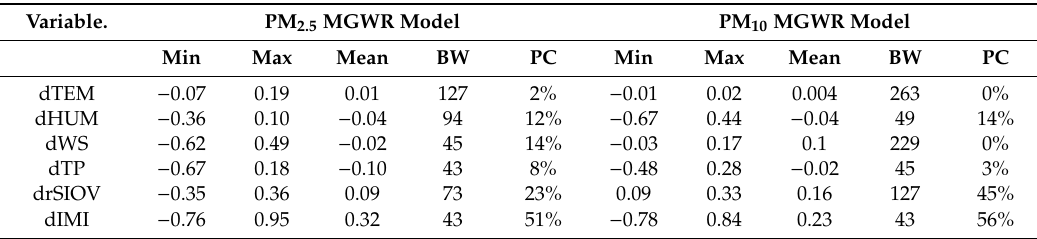
Table 7. Some information about the coe ffi cients in two MGWR models. BW is the optimal bandwidth of each variable, and PC is the proportion of coe ffi cients passed by significance test ( α = 0.05).